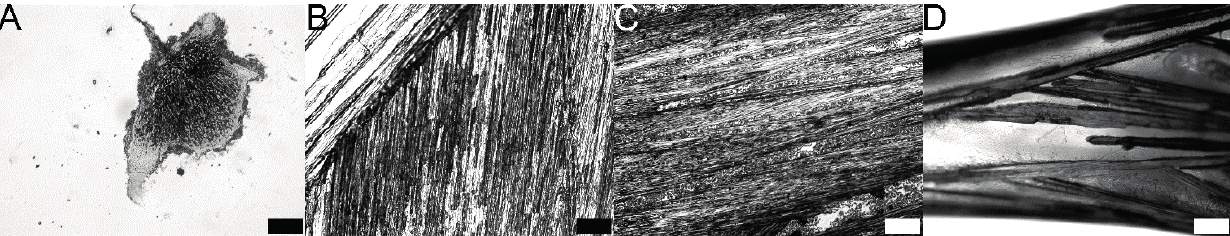
Figure 2. Brightfield microscope image of urea crystals. ( A ) Formed by uncontrolled crystallization from solutions of urea in formic acid (scale bar, 200 μ m); ( B ) Formed by uncontrolled crystallization from solutions of urea in hexafluoroacetone hydrate (scale bar, 200 μ m); ( C ) Formed by uncontrolled crystallization from solutions of urea in hexafluoroisopropanol (scale bar, 200 μ m); and ( D ) Formed by controlled crystallization from solutions of urea in hexafluoroisopropanol in a Pasteur pipette (scale bar, 500 μ